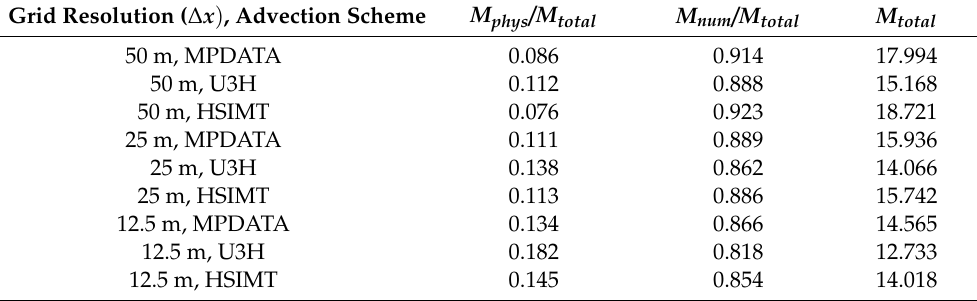
Figure 3. Case 3: Lock exchange problem using the Multidimensional Positive Definite Advection Transport Algorithm (MPDATA) scheme with a ∆ x of 50 m, ( a ) Along channel salinity profile (15 psu isohaline) and velocity vectors (drawn to scale) varying with depth at ( t = 0 h, t = 0.5 h, t = 1.1 h, t = 2.2 h), ( b ) Flux Richardson number ( R f ) at x = 3.85 km at the end of simulation. Table 3. E ff ect of grid resolution on physical and numerical mixing using test case 3, the lock exchange. Comparing physical, numerical mixing with total mixing. Column 1: M phys / M total = Ratio of numerical to total mixing; Column 2: M num / M total = Ratio of physical to total mixing; Column 3: M total = Total mixing (non-dimensionalized by total volume) in in (psu) 2